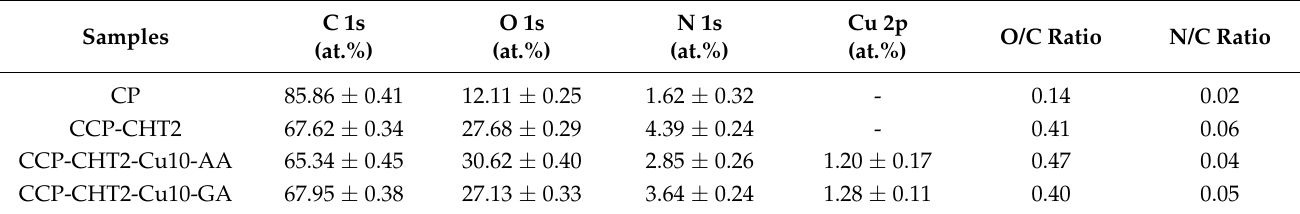
Figure 5. Survey XPS spectra of CP, CCP-CHT2, CCP-CHT2-Cu10-AA, and CCP-CHT2-Cu10-GA samples. Table 2. Relative chemical composition (at.%) and atomic ratios on the surface of CP, CCP-CHT2,